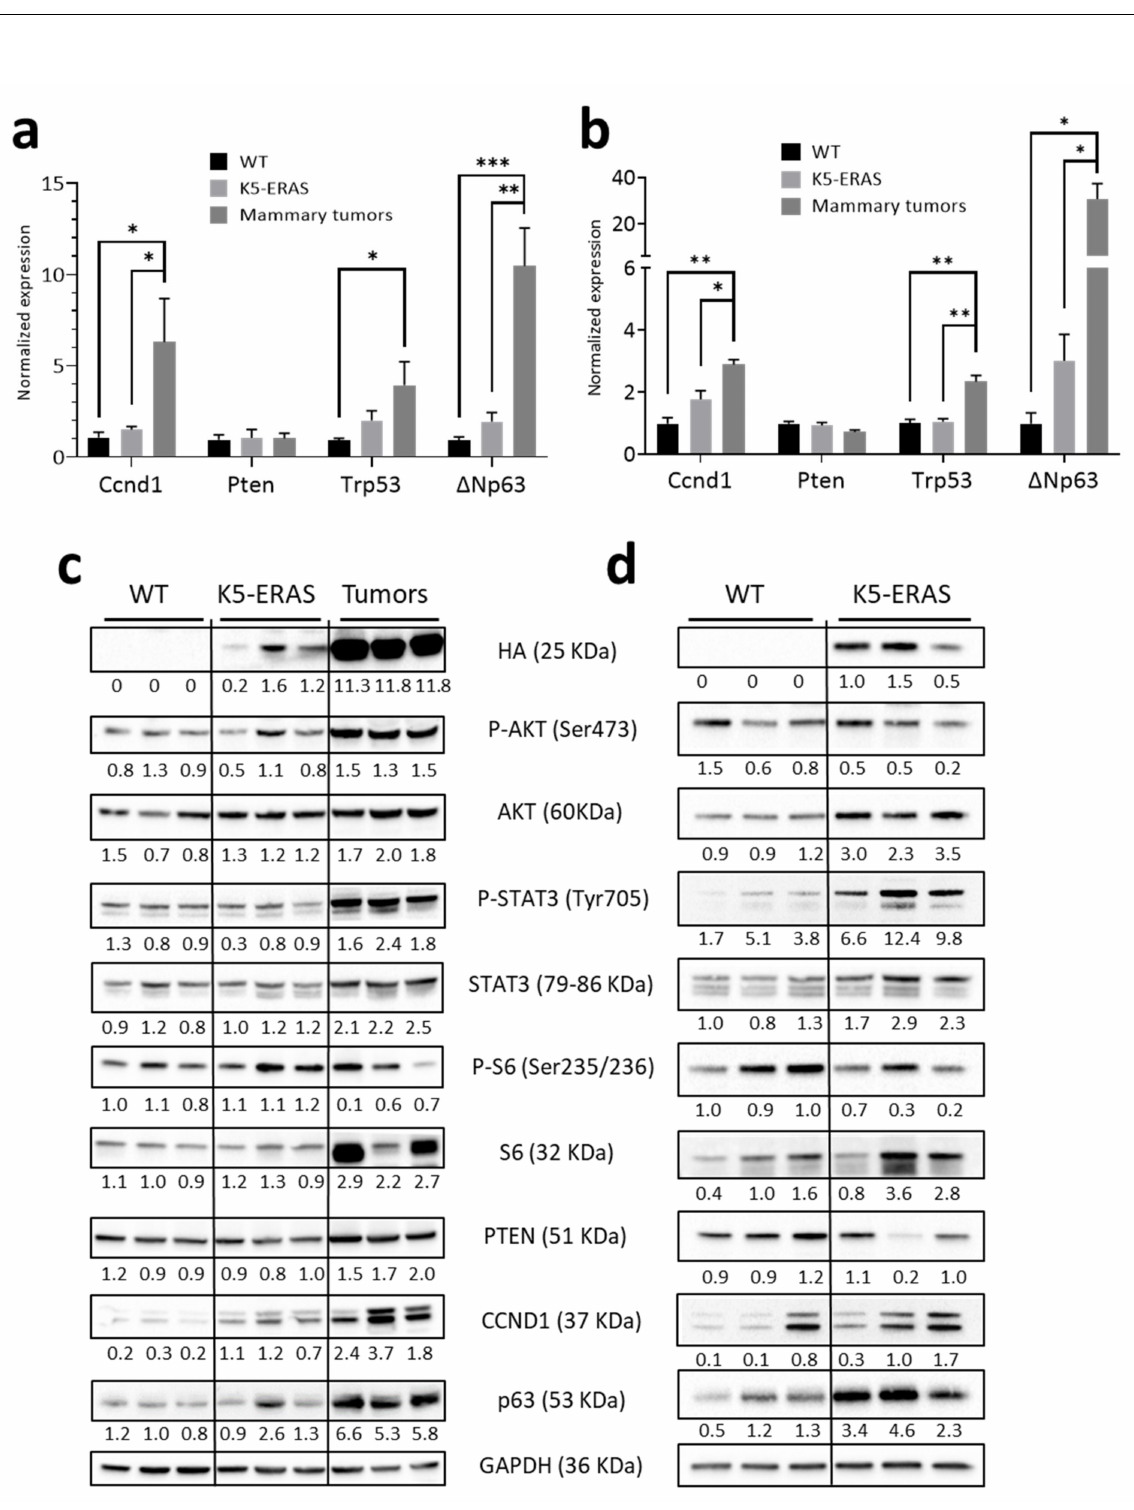
Figure 9. Biochemical characterization of K5-ERAS mammary glands and tumors. ( a , b ) RT-qPCR analyses of the expression of genes implicated in proliferation and tumoral transformation in mammary glands of 17.5-day pregnant WT and K5- ERAS mice, as well as in K5-ERAS mammary tumors ( a ) and in virgin mammary glands ( b ). ( c ) Western blot analysis of three different samples of mammary glands from 17.5-day pregnant WT and K5-ERAS mice, and of K5-ERAS mammary tumors. ( d ) Similar study in mammary glands from virgin animals. In ( c , d ), phosphoproteins are normalized against the corresponding total proteins. We used between 3 and 5 samples of each genotype for the results included in ( a ) and three samples per genotype in ( b ). * p < 0.05; ** p < 0.01; *** p <